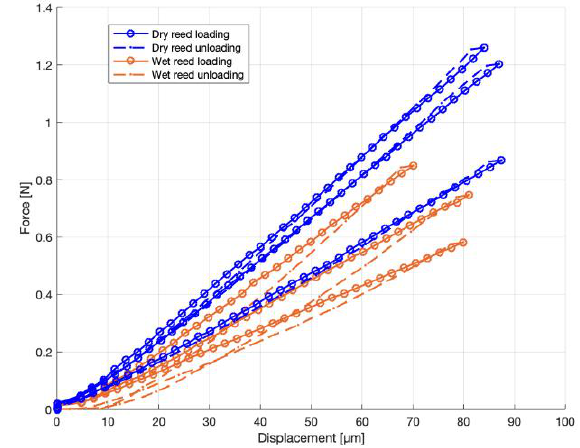
Figure 5. Force–displacement curves of dry and wet reed samples in the longitudinal direction.